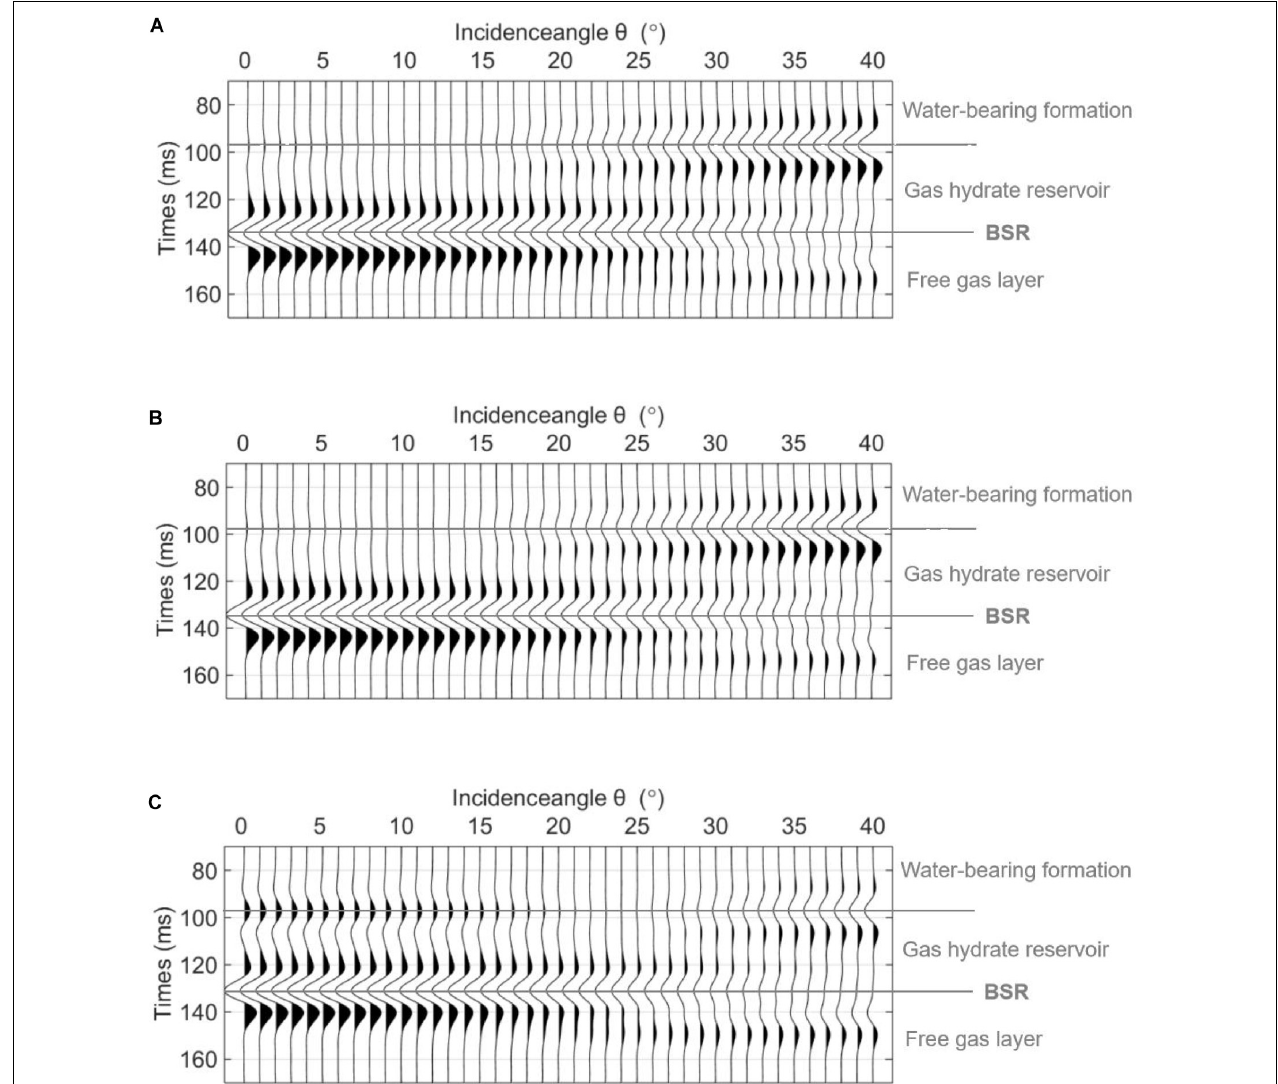
FIGURE 9 | The PP AVO responses for different hydrate saturations S. (A) S = 0.2, (B) S = 0.35, and (C) S =